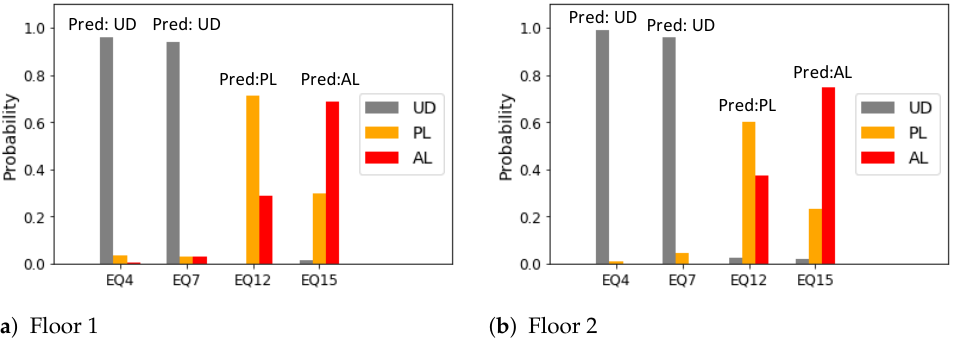
Figure 13. Damage pattern predictions of a single earthquake in test set using the ARI(7,1)